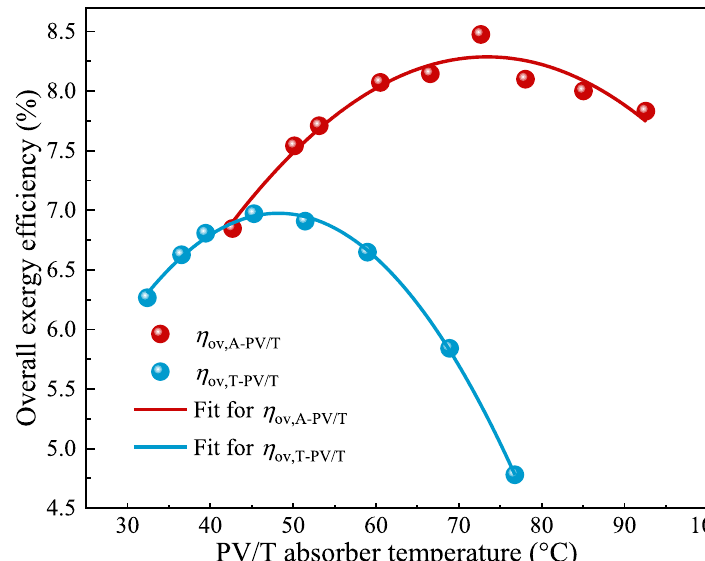
Fig. 11 Overall exergy efficiency of the A-PV/T and T-PV/T at different